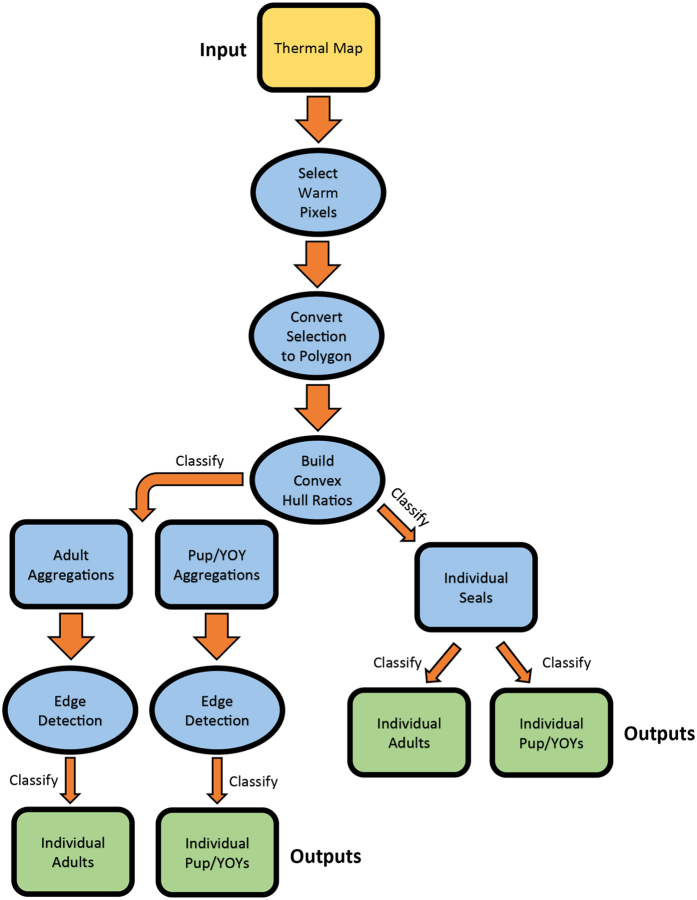
An overview of the seal detection model’s logical processes.Yellow icons are inputs, blue icons are intermediate processes and outputs, and green icons are final outputs.